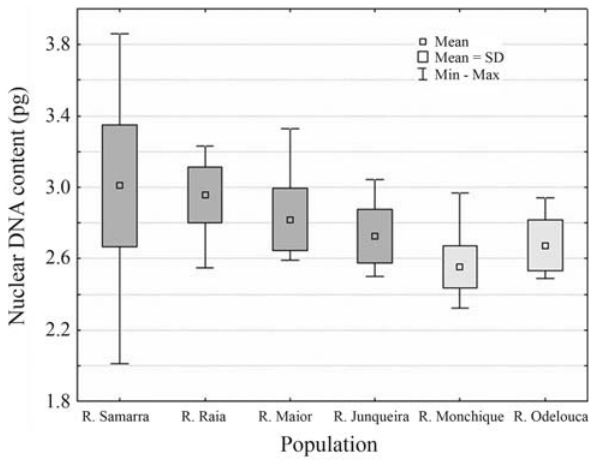
Figure 5 - Mean values, (cid:3) SD and range of DNA content variation ob- tained by flow cytometry in the populations of Iberochondrostoma lusitanicum (dark grey) and I. almacai (light